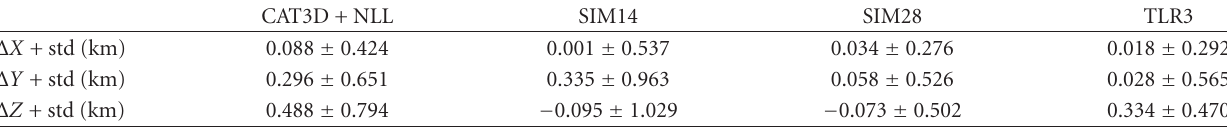
Table 3: Average shift and standard deviation of the hypocenter distributions calculated by the di ff erent methods. Δ X + std